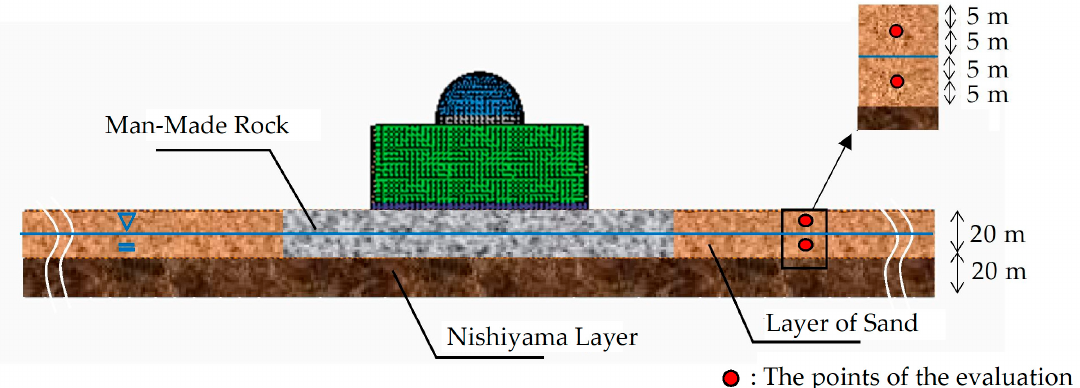
Figure 10. Schematic view of the part of the soil, rock and man-made rock; the points to be evaluated are shown in red-circles. Table 2. Deformation characteristics parameters of the soil and rock used for the simulation. The parameter designations are illustrated in [9].